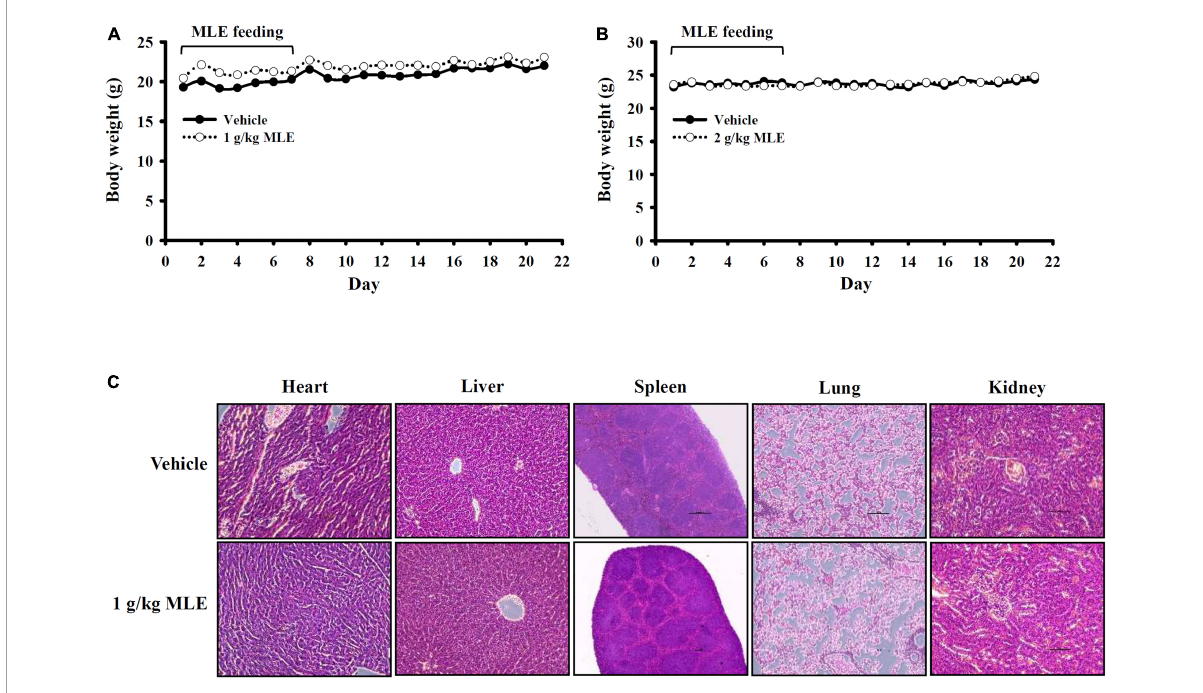
FIGURE6 Preliminary safety evaluation of mice exposed to MLE. (A,B) Effect of MLE on body weight. (C) H&E staining of tissue sections from vehicle- or MLE-fed mice.